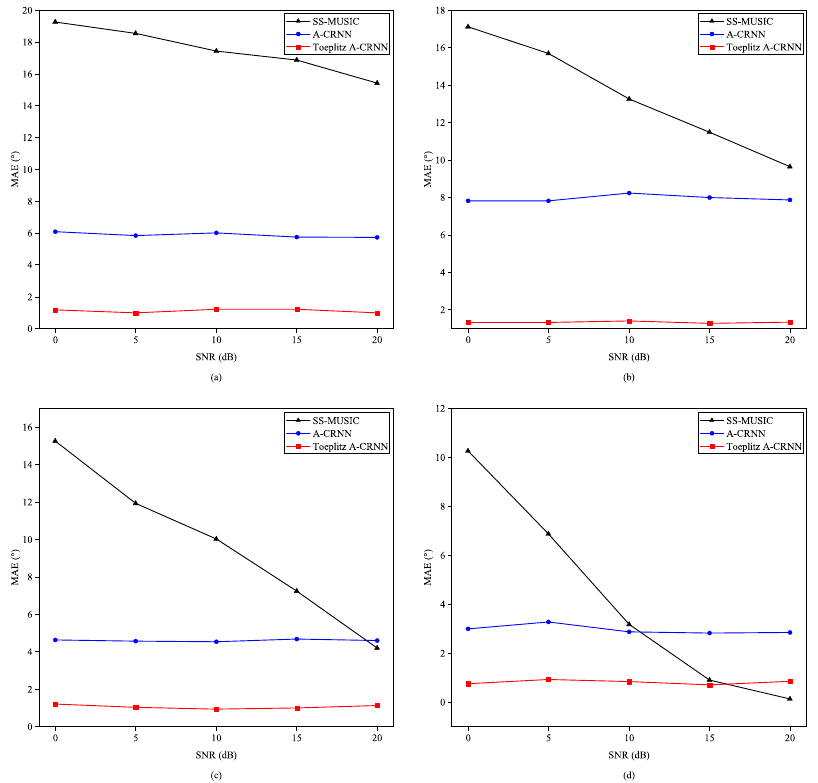
Figure 8. MAEs for direction combinations in the testing set with variable SNR levels and different angle intervals: ( a ) Angle interval = 3 ◦ . ( b ) Angle interval = 5 ◦ . ( c ) Angle interval = 8 ◦ . ( d ) Angle interval = 12 ◦